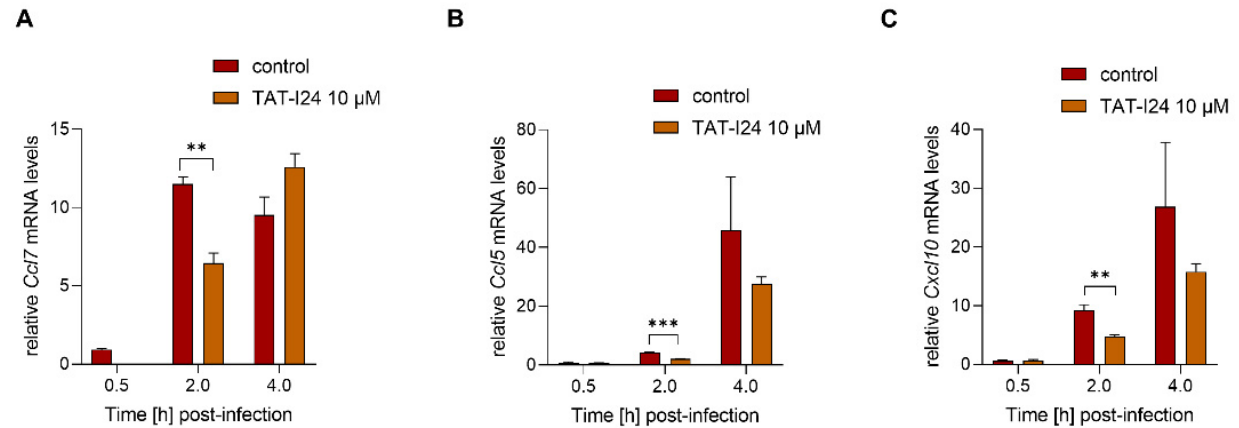
Figure 6. Levels of host-cell transcripts relative to the housekeeping gene Gapdh in cells infected with UV-irradiated MCMV (MOI 2.5) either untreated or treated with 10 µ M TAT-I24. Fold change in transcripts levels (mean ± standard error of the mean) of Ccl7 ( A ), Ccl5 ( B ), or CxCl10 ( C ) from three independent experiments is shown. Multiple t-test was used for statistical analysis; ** statistically significant at p ≤ 0.01, *** statistically significant at p ≤